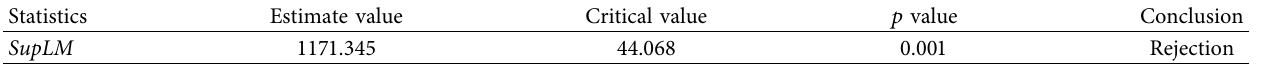
Table 6: Test results of SR and CPI threshold